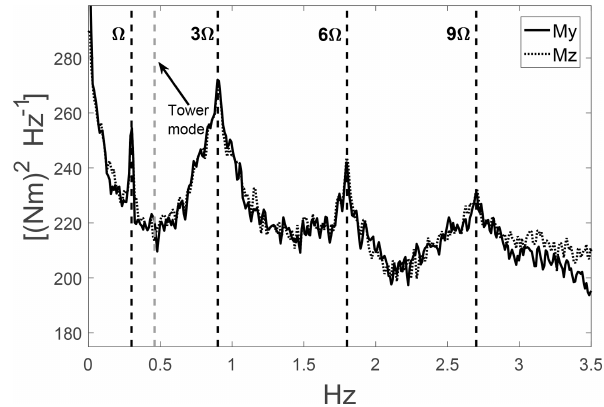
Figure 5. Power spectra of WT hub out-of-plane moments in the stationary frame. Prominent peaks can be seen to occur at multiples of 3 (cid:127) .